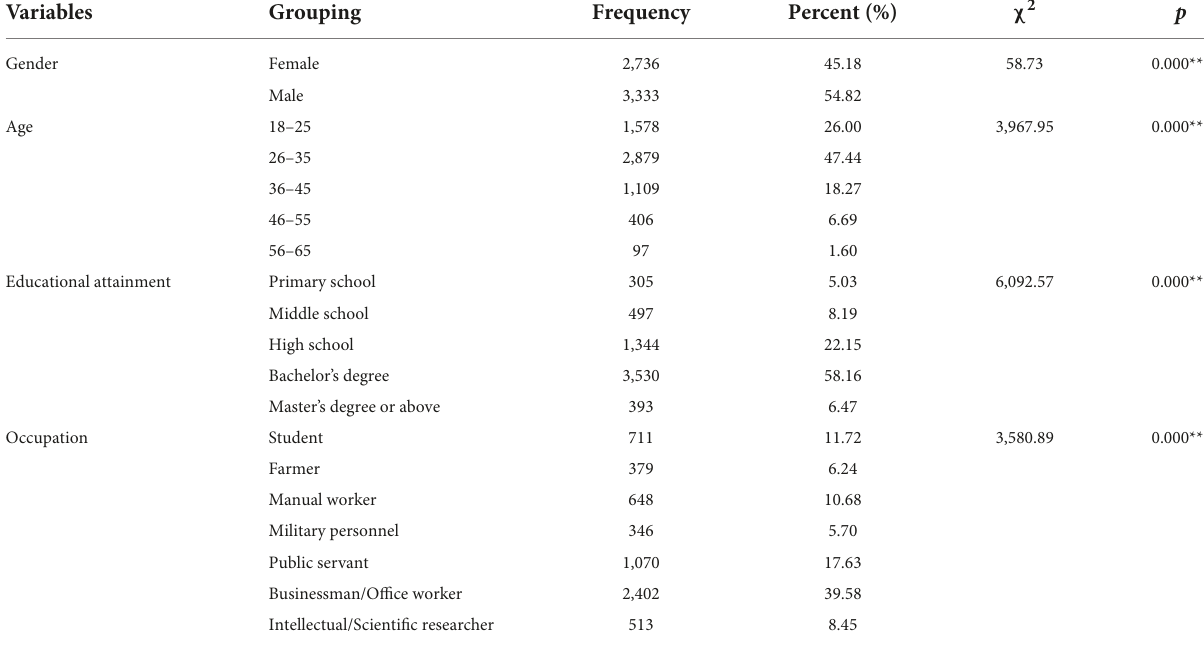
TABLE 1 Descriptive characteristics of the participants ( n =